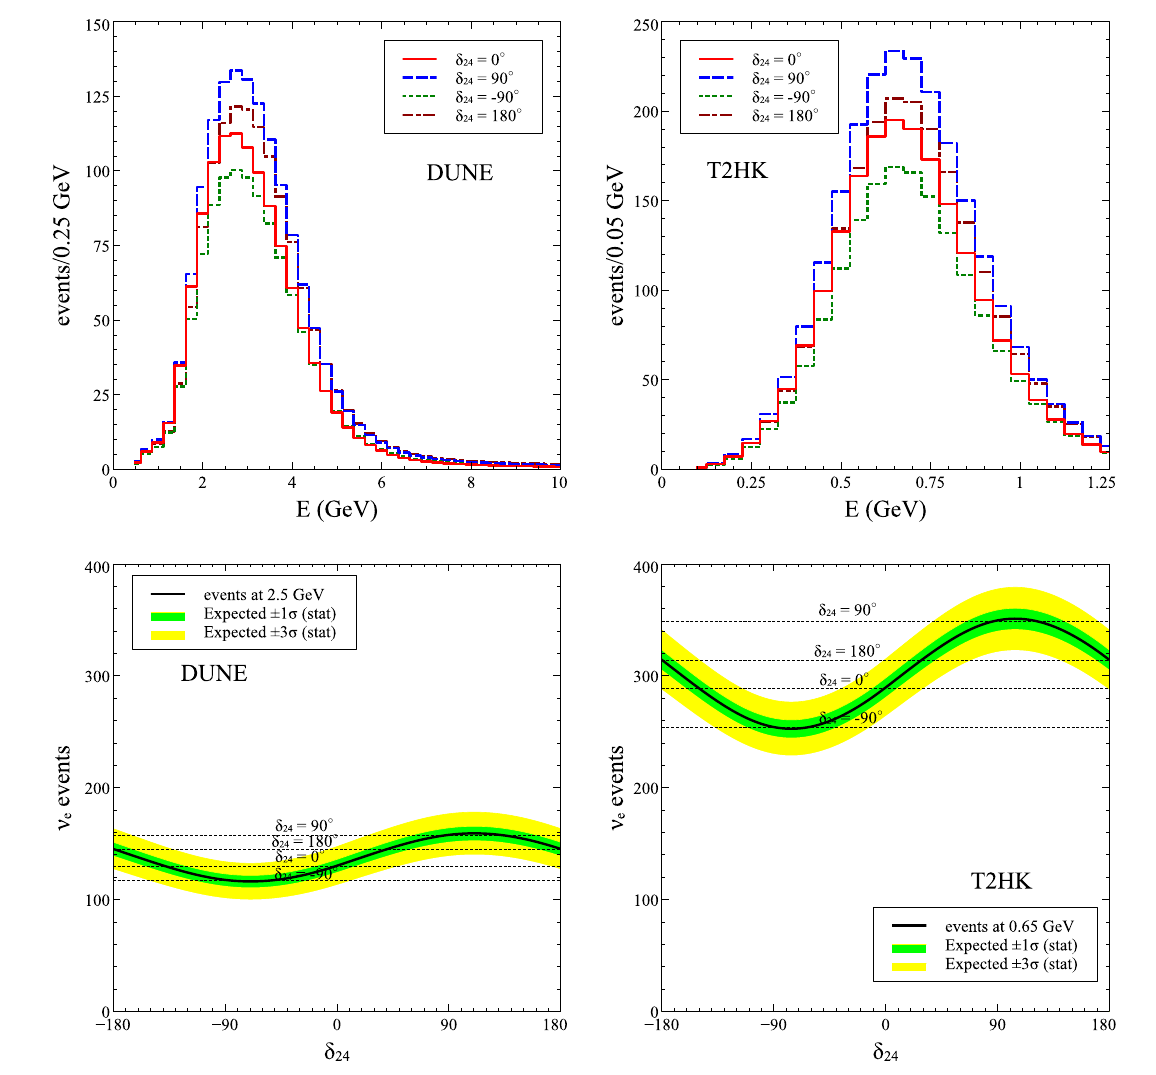
Fig. 2 ToppanelsshowtheappearanceeventspectrumforDUNE(left) appearance event rates at the oscillation maximum as a function of δ 24 and T2HK (right) for different values of δ 24 The green lines are for for DUNE (left) and T2HK (right). While the black curves give the δ = − 90 ◦ , red lines are for δ = 0 ◦ , the blue lines are for δ = 90 ◦ expected number of events, the green and yellow bands show the 1 σ 24 24 24 and 3 σ statistical uncertainties and the dark red lines are for δ 24 = 180 ◦ . The lower panels show the